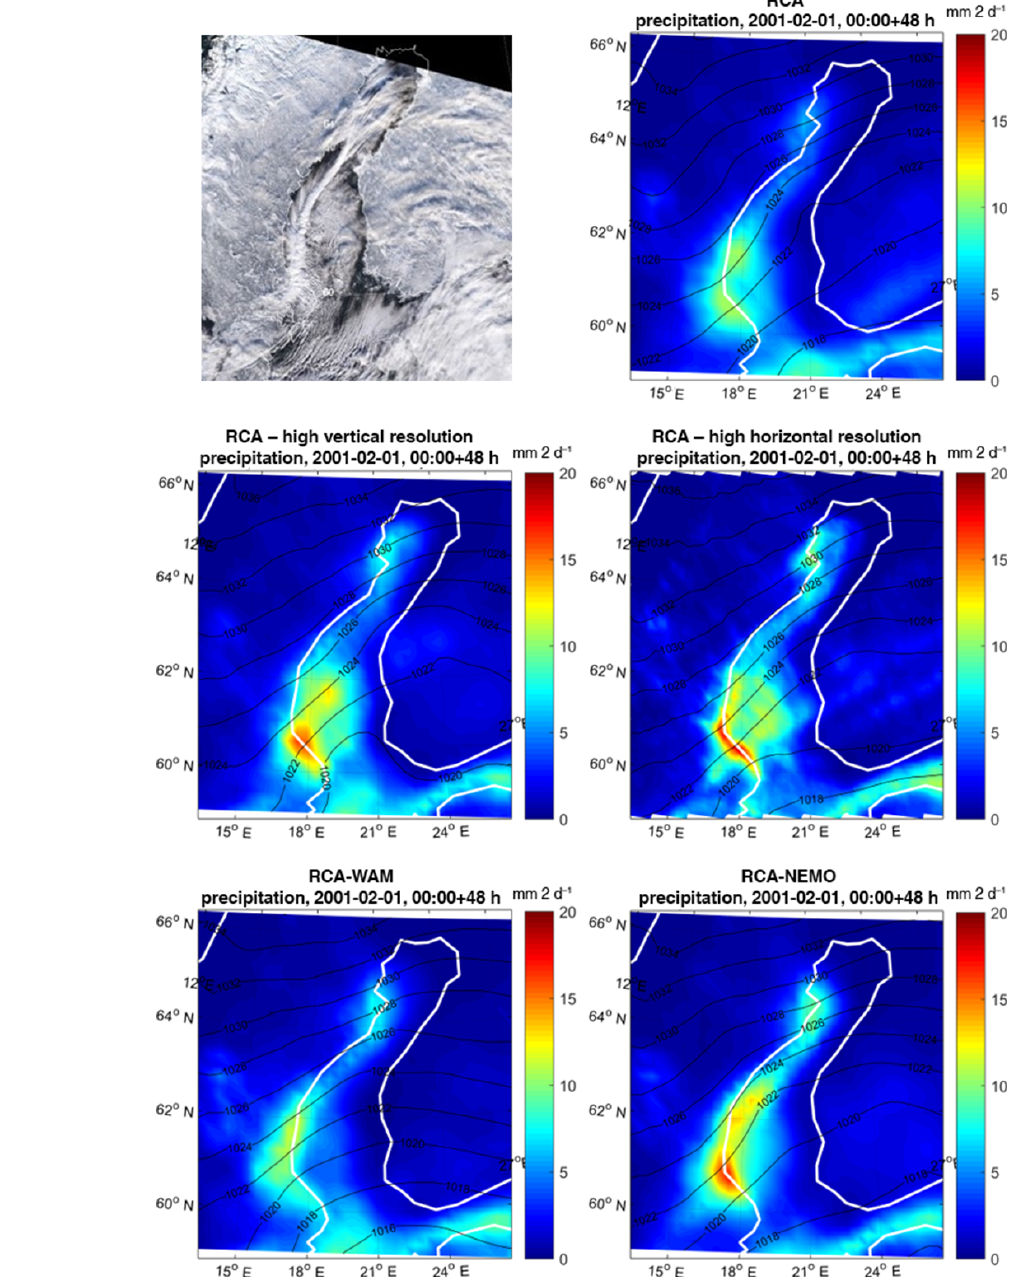
Figure 10. The 2-day accumulated total precipitation of all models for case 1 in comparison and a cropped satellite image of 1 Febru- ary 2001 (MODIS,